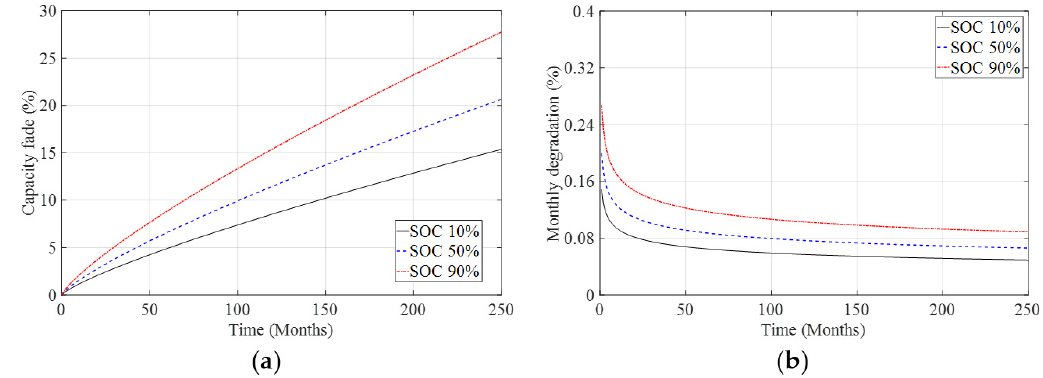
Figure 5. Calendar life model: ( a ) capacity fade by calendar deterioration, and ( b ) monthly degradation. A calendar degradation model with monthly time units is not appropriate for FR-ESS in